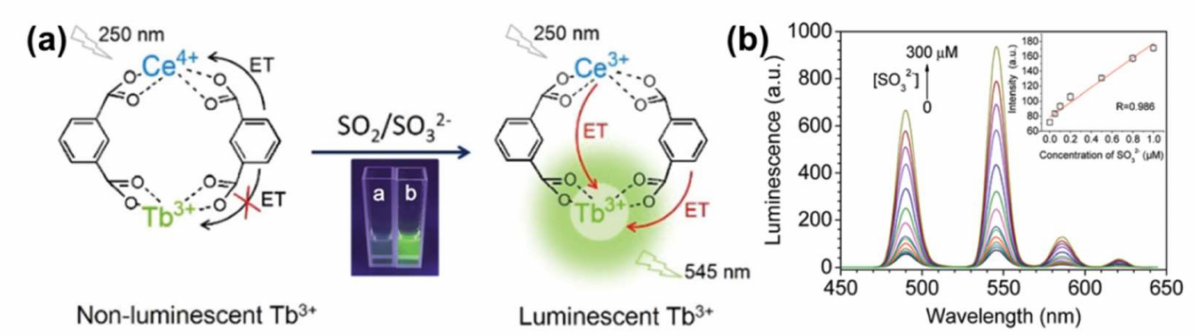
Figure 6. ( a ) Diagram of the Ce 4+ /Tb 3+ based Ln-MOF for sensing SO 2 and sulfite via the turn-on of luminescence induced by energy transfer (ET) triggered by redox-reaction. ( b ) The luminescence of Ln-MOF increases with the concentration (0, 0.05, 0.1, 0.2, 0.5, 0.8, 1, 5, 20, 50, 100, 150, 200, and 300 mM) of SO 32 − ; the inset shows the linear relationship of the luminescence intensity of Ce-PA-Tb at 545 nm with the concentration of SO 32 − . Adapted from